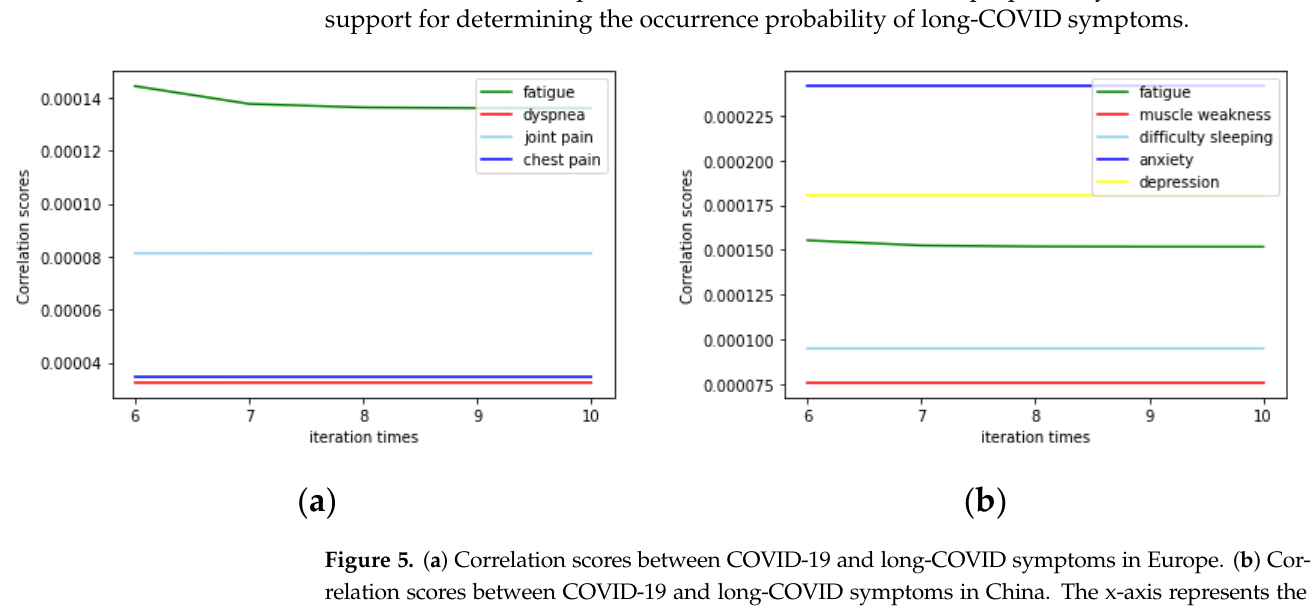
23 Table 4. Distribution frequency of the path module correlation coefficients between two modules including 10, 50, 100, 150, 200 nodes. All of the coefficients fall into the [0.1, 1.5) interval, most coef- ficients fell into the [0.3, 0.9) interval, and a small number of coefficients fell into the [0.9, 1.5) inter- val. Distribution Interval